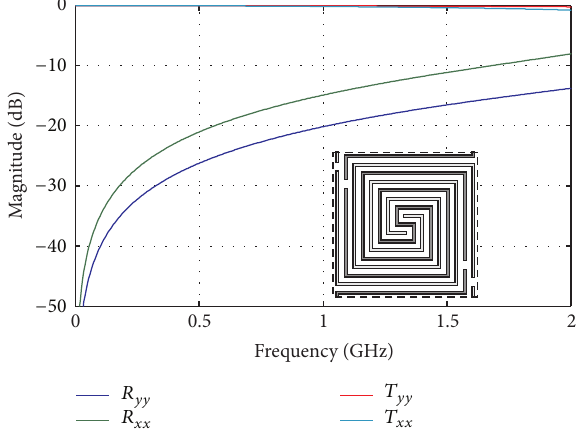
Figure 3: Off state transmittance and reflectance of the AFSS of Figure 1 at normal incidence of x - and y -polarized waves when two additional breaksand ideal switches arecontained inthespiralarms.